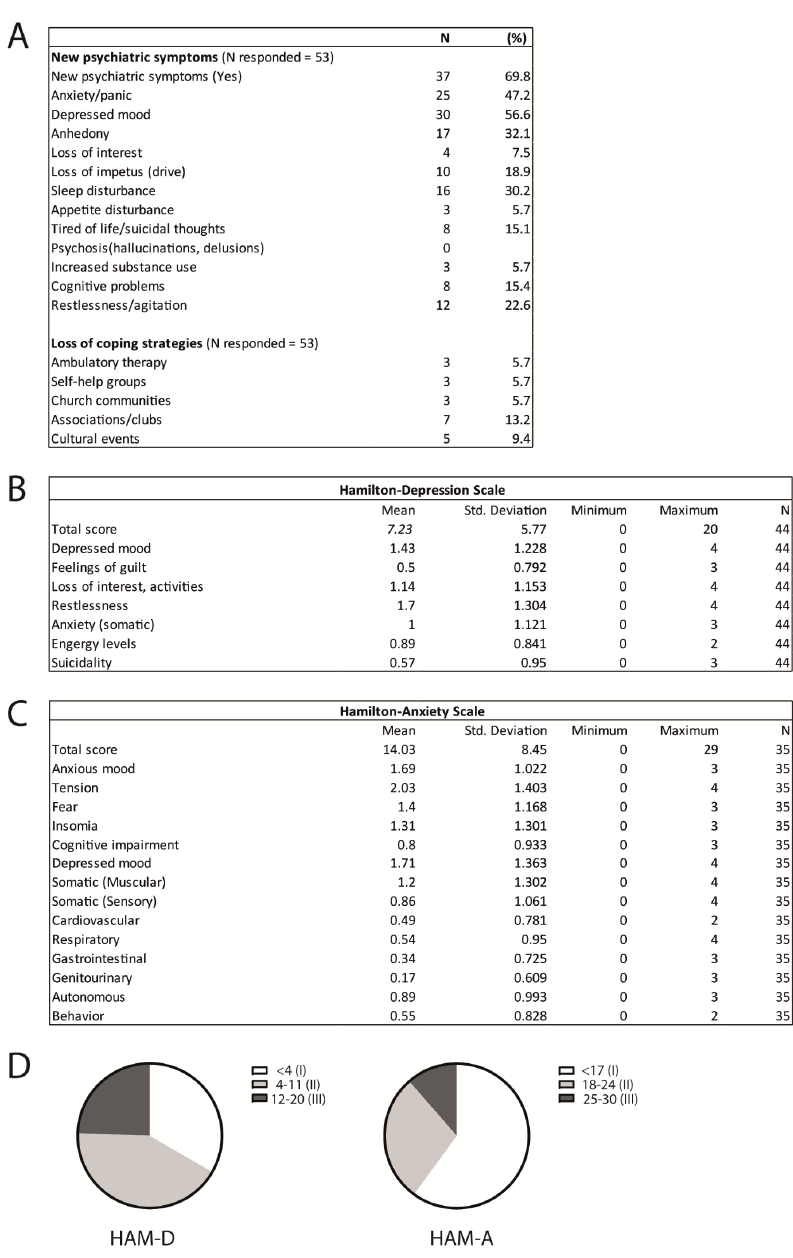
Figure 3. ( A ) Reported new psychiatric symptoms and loss of coping strategies during the COVID-19 pandemic. N responded = the number of callers who were willing to answer the question. N repre- sents the number of callers who affirmed the specific information and features asked. The percentage was calculated as (N/N responded) * 100. ( B ) Mean scores and frequency of the Hamilton Depression Rating Scale (HAM-D) and ( C ) the Hamilton Anxiety Rating Scale (HAM-A) assessments. ( D ) Pie charts revealing the level of depressive or anxiety symptoms: A third (33.3%) showed no depressive symptoms (I) versus 42.2% with mild levels (II) and 24.4% with moderate levels (III). For the HAM-A, 60% of callers showed mild levels of anxiety (level I) versus 28.6% with moderate (II) and 11.4% with moderate to severe (III) levels of anxiety. We found neither severe (level IV) depressive nor anxious symptoms among the